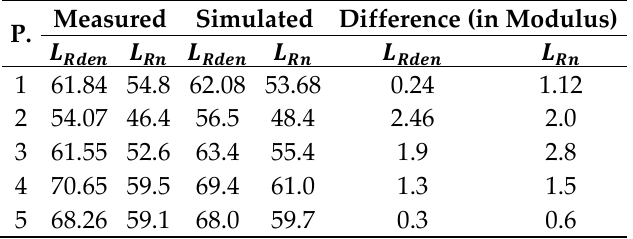
Table 2. Comparison between measured and simulated values .